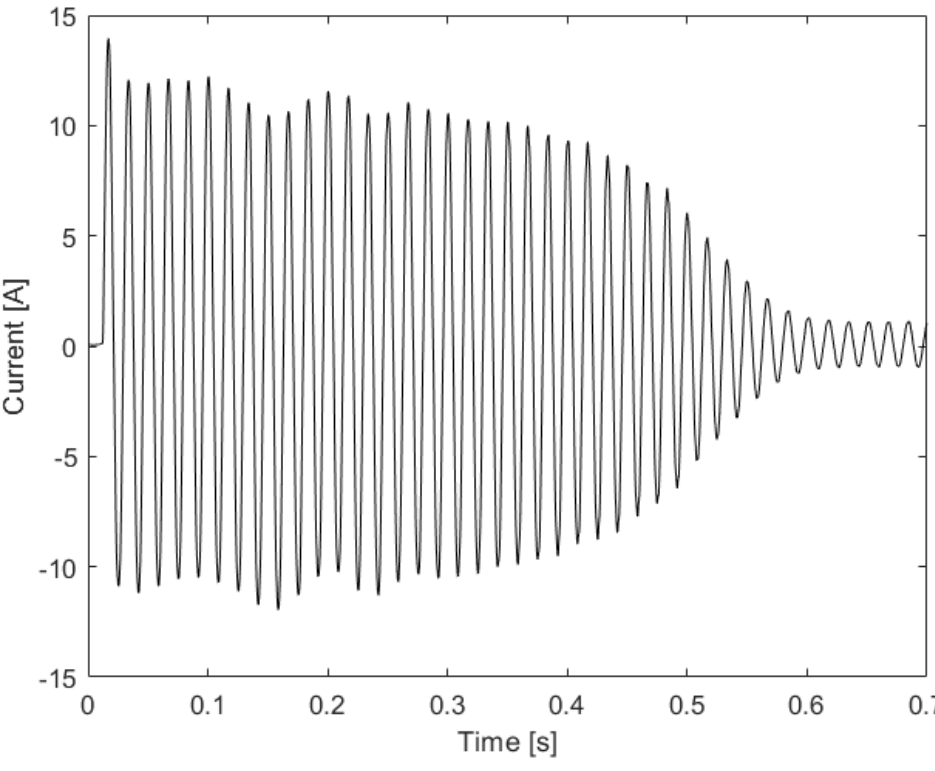
Figure 3. Measured startup current for the rotor with one bar partially broken (½